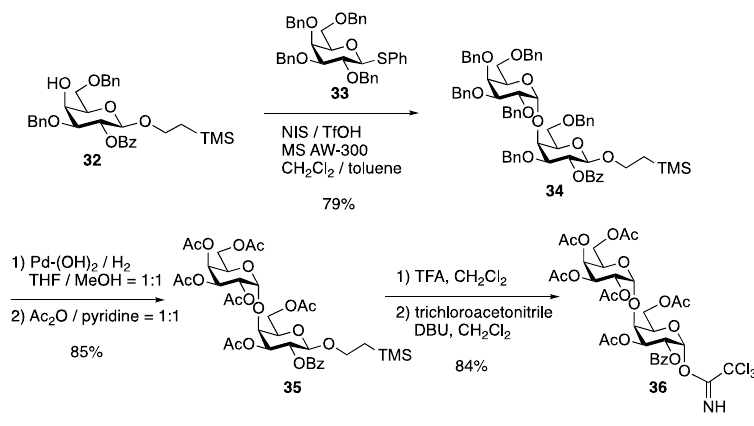
Figure 5. Revised synthetic strategy for compounds A and B .